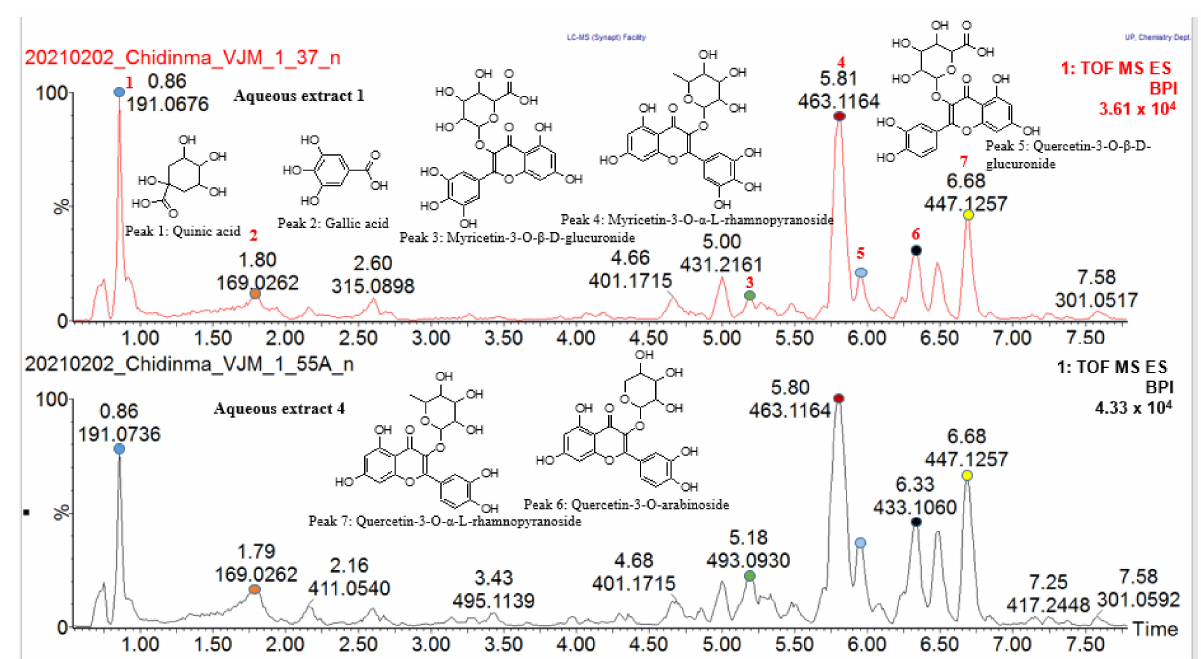
Figure 3. ESI negative mode BPI chromatogram of active S. birrea spray-dried aqueous leaf extracts (aqueous extracts 1 and 4) with expansion of region from 0 to 7 min. Seven compounds were tentatively identified by comparing their accurate masses and MS/MS fragmentation patterns with compounds in databases such as Metlin, Metfusion, Chemspider, Pubchem, Dictionary of Natural Products and Waters UNIFY ® Scientific Information System.